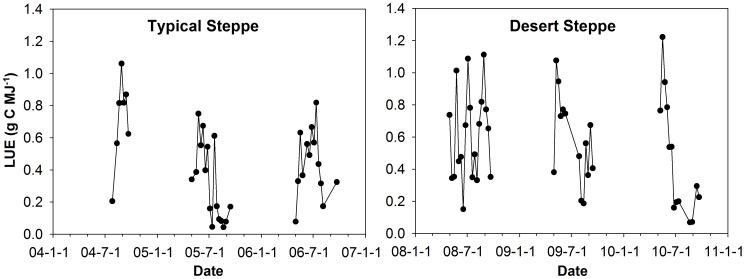
Seasonal variations of light use efficiency (LUE) at the two sites.LUE was calculated by dividing GPP by PARa (FPAR*PAR).